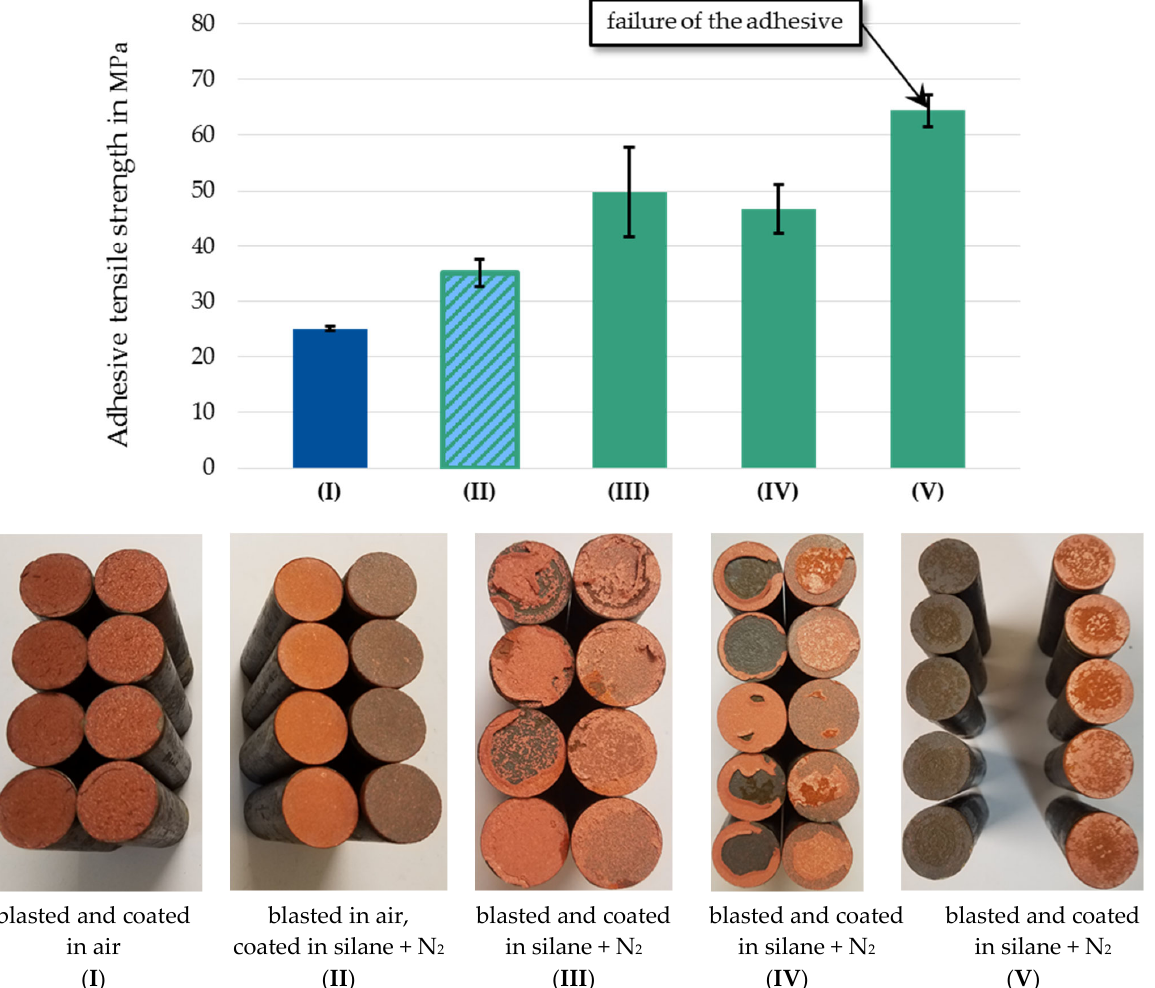
Figure 7. Adhesive tensile strengths and fracture surfaces of wire arc sprayed copper coatings upon blasting and coating in different environments.